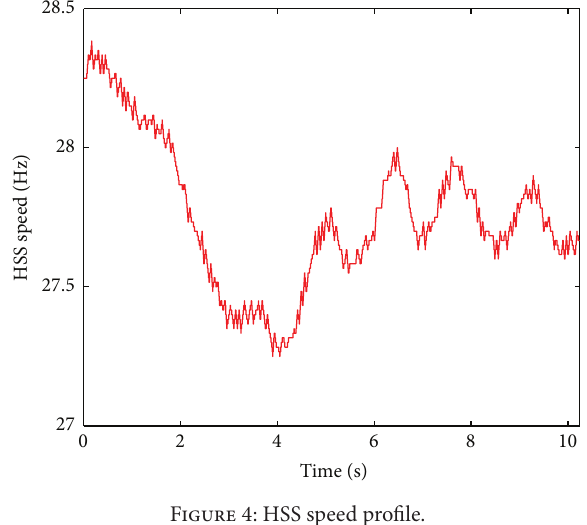
Figure 4: HSS speed profile.